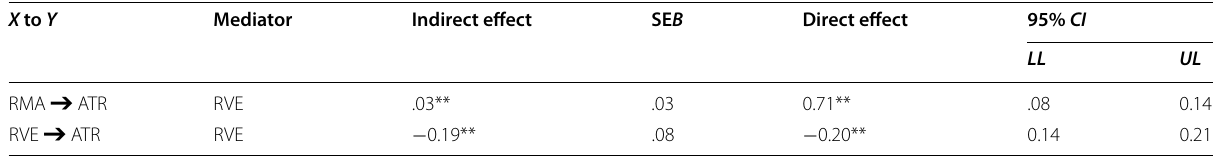
Table 6 Mediation effect of rape victim empathy between rape myths acceptance and attitudes towards rape